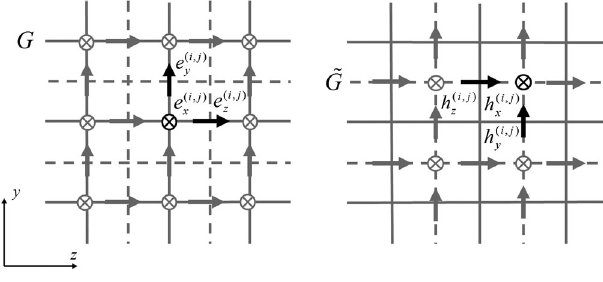
FIG. 4. Grid doublet ð G;